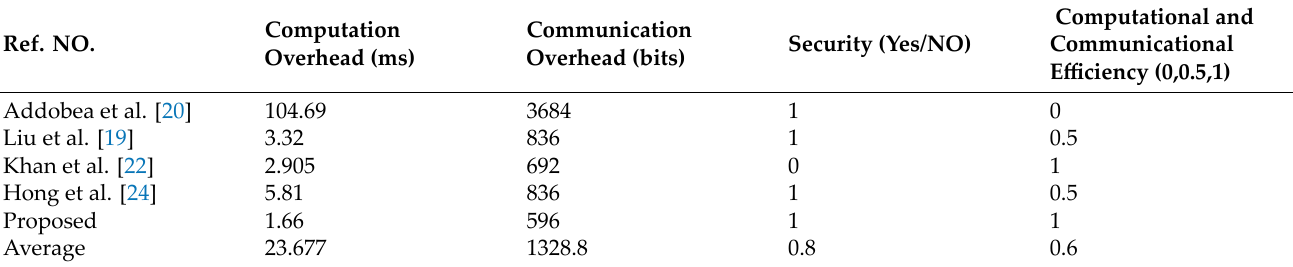
Table 11. Average of the selected